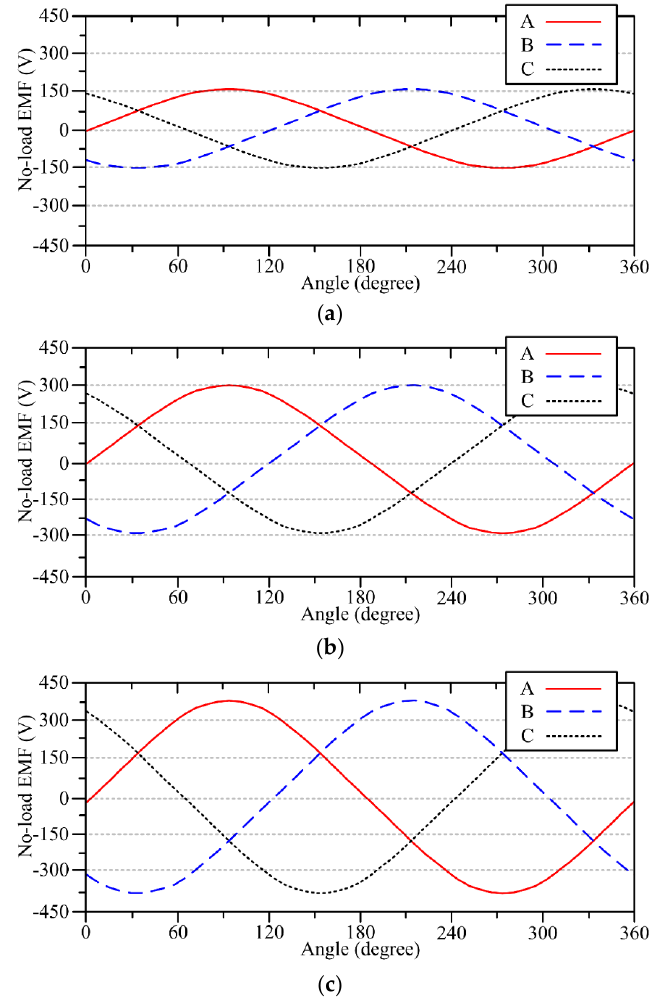
Figure 8. No-load EMF waveforms: ( a ) IR-VPM; ( b ) OR-VPM and ( c ) OR-CP-VPM.